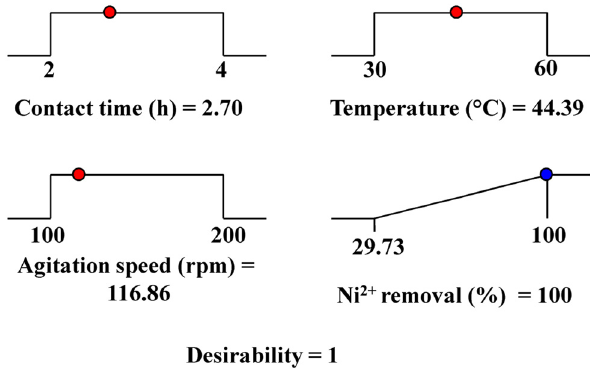
Figure 4: The optimization plot displays the DF and the optimum predicted values for the maximum percentage for biosorption of Ni 2 + ions by G. amansii biomass from aqueous solution.